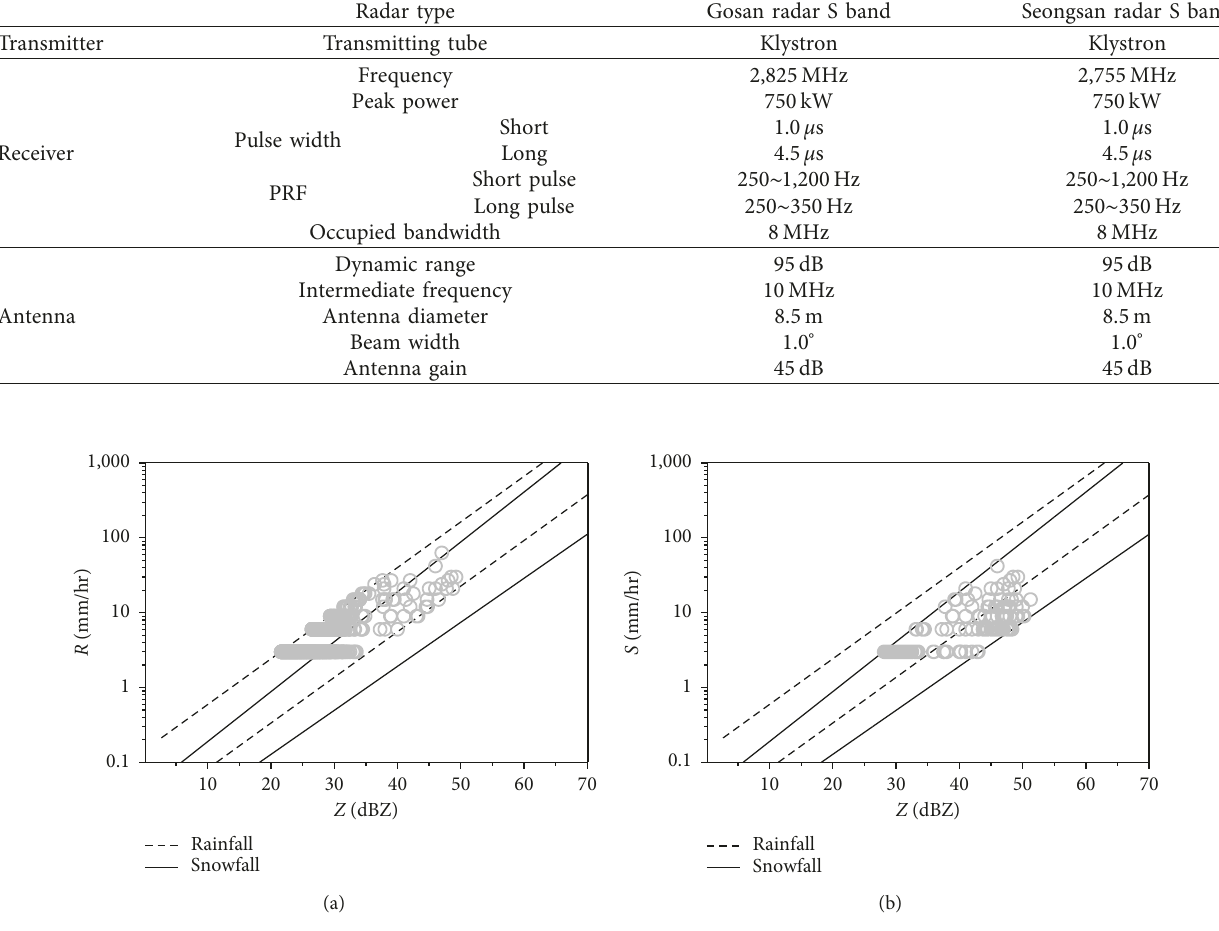
Figure 5: Comparison of observed (a) rainfall and (b) snowfall data along with their radar reflectivity collected over the elevation zone of 250 ∼ 500 m (data collected during winter from 2007 to 2016).